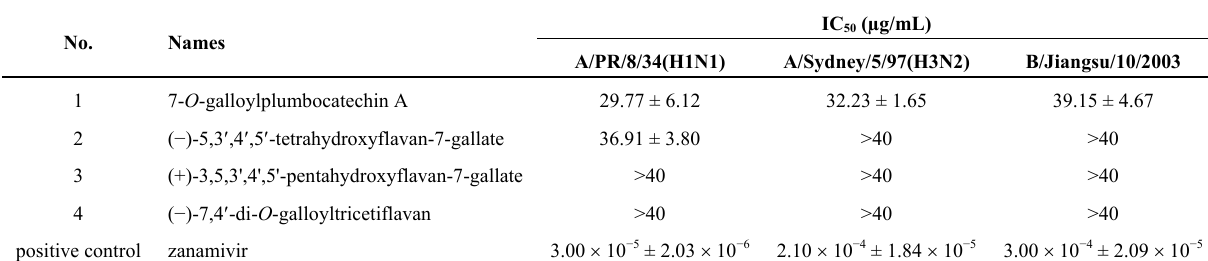
Table 1. The flavonoids from P. clypearia in this study and their inhibitions on NAs of influenza A and B